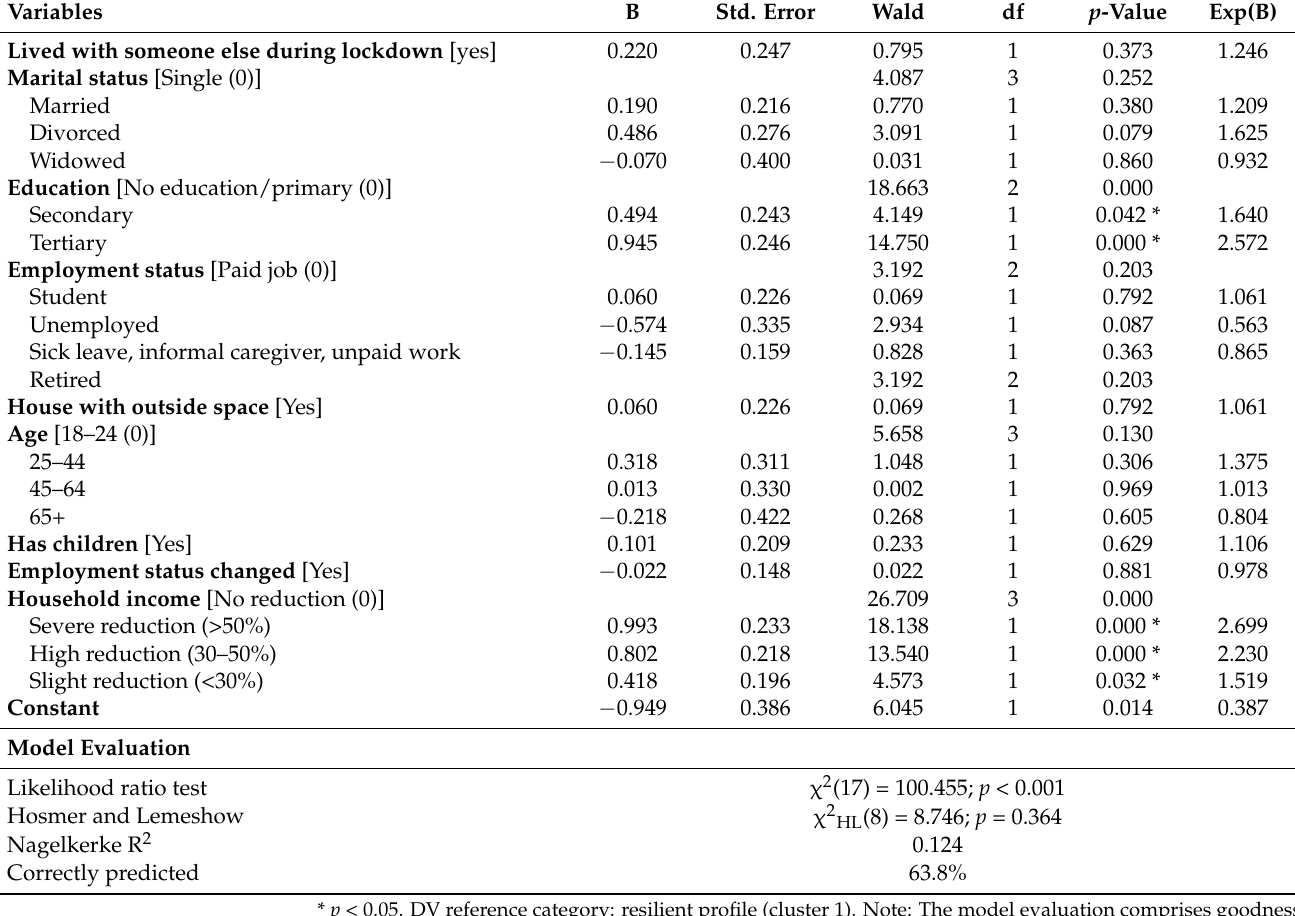
Table 2. Model 1—Socioeconomic determinants of the profiles of social impacts of the